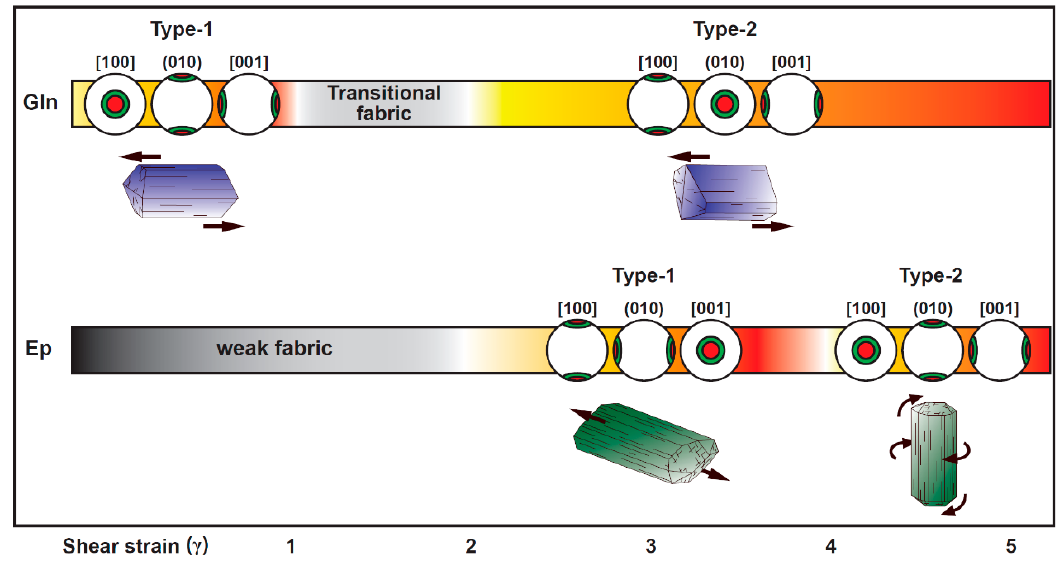
Figure 11. Schematic of the development of LPOs of glaucophane and epidote with increasing shear strain. Gln: glaucophane; and Ep: epidote.